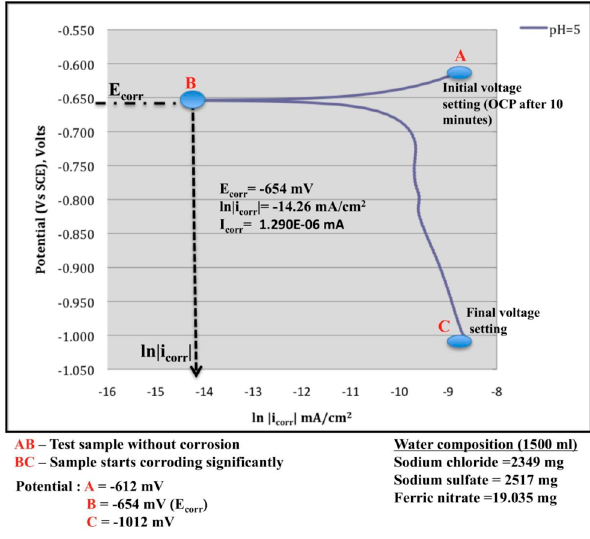
Figure 16. Tefel plot for a test steel sample [55].